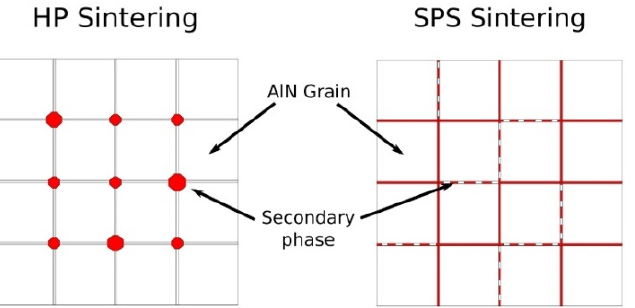
Figure 17. Schematic representation of the microstructure of AlN + CeO 2 sintered samples obtained by HP and SPS.